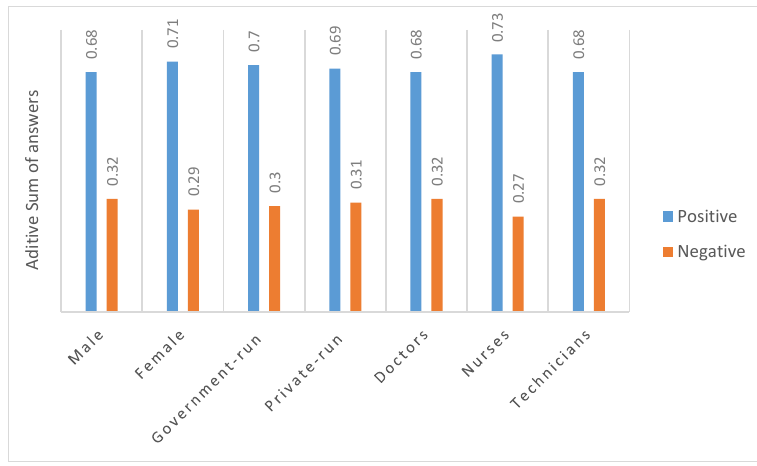
Fig. 3: Module 2 additive sums of positive answers (blue) and negative answers (orange)